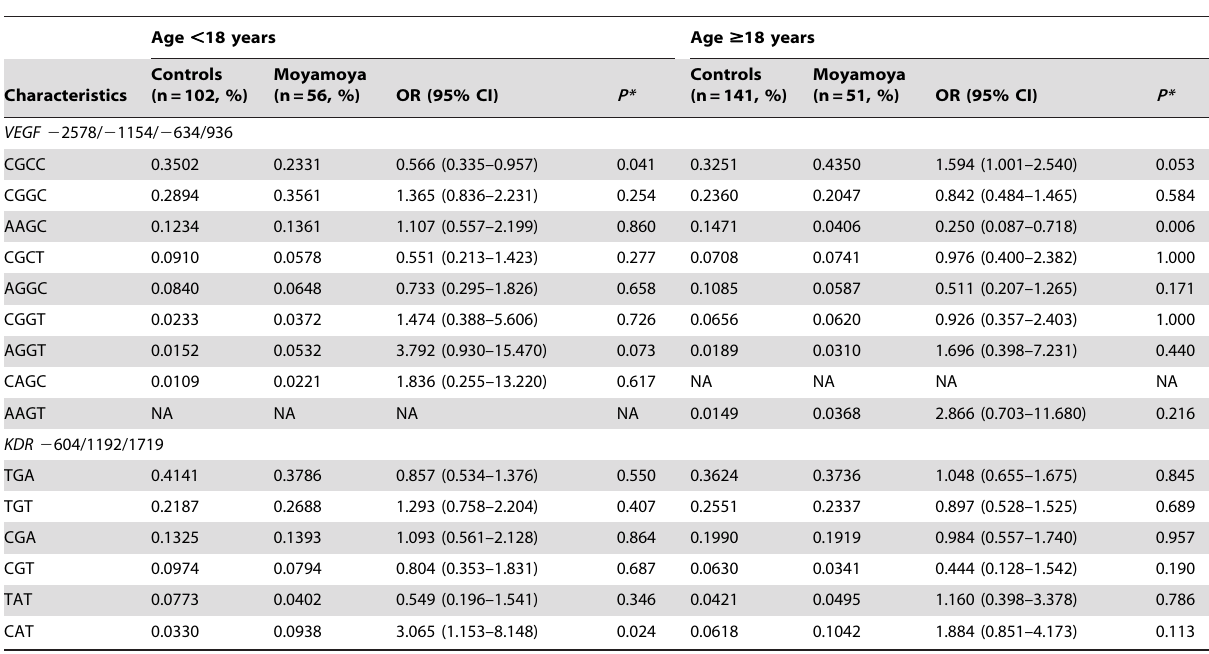
Table 6. Haplotype frequencies of the VEGF a nd KDR polymorphisms according to